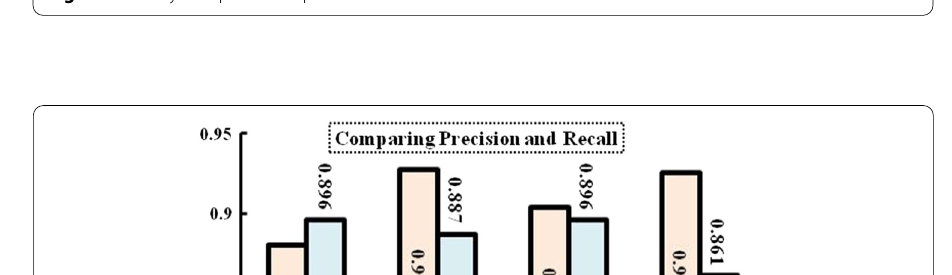
Fig. 2 Accuracy comparison of prediction models